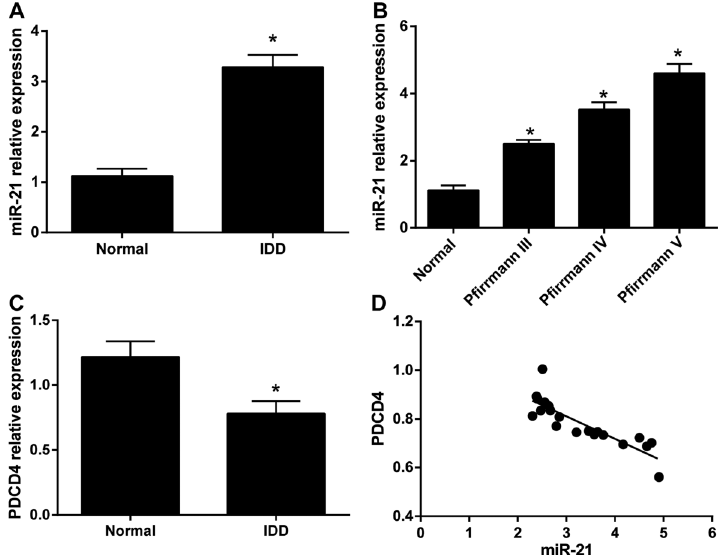
degeneration (IDD) and from normal controls. B , miR-21 expression from healthy controls and patients with P fi rrmann III, IV, V; C , programmed cell death 4 mRNA (PDCD4) expression in healthy controls and IDD patients; D , correlation analysis of miR-21 expression and P fi rrmann grades. *P o 0.05, compared with normal controls (Student t